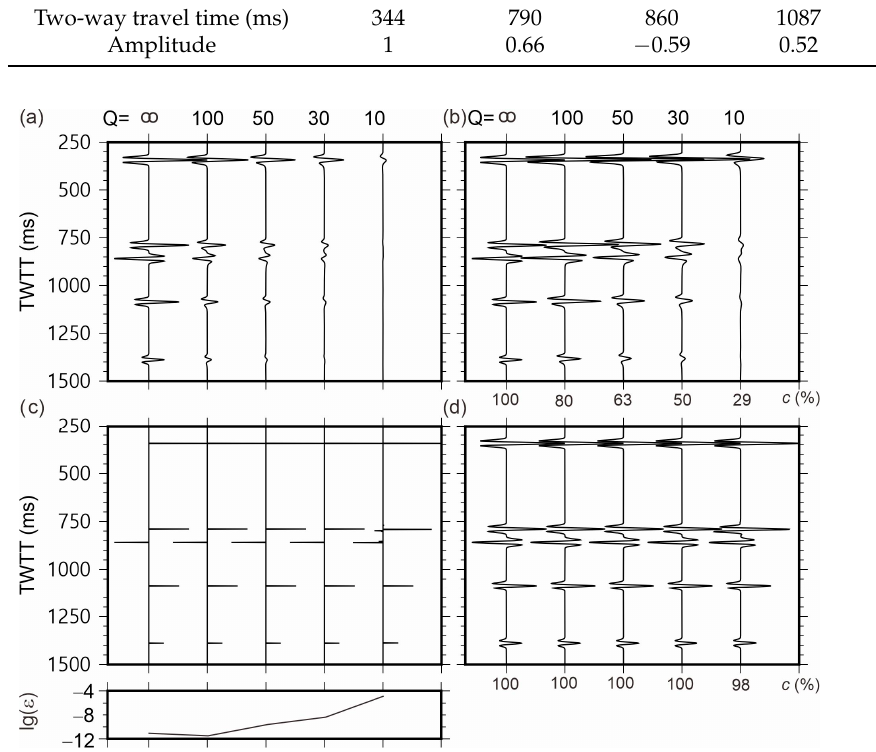
Figure 1. Test of Q -compensation methods using noise-free data: ( a ) data with Q = ∞ , 100, 50, 30, and 10 (trace labels) obtained by forward modeling in the reflectivity model in Table 1; ( b ) stabilized inverse- Q filtering; ( c ) reflectivity model produced by ITD; ( d ) waveforms Q -corrected by ITD. For Q ≥ 30, this model also exactly corresponded to the input reflectivity model labeled by Q = ∞ . Below plot ( c ), a graph of logarithms of residual data energies is shown (Equation (12)). Label TWTT denotes the two-way travel time.